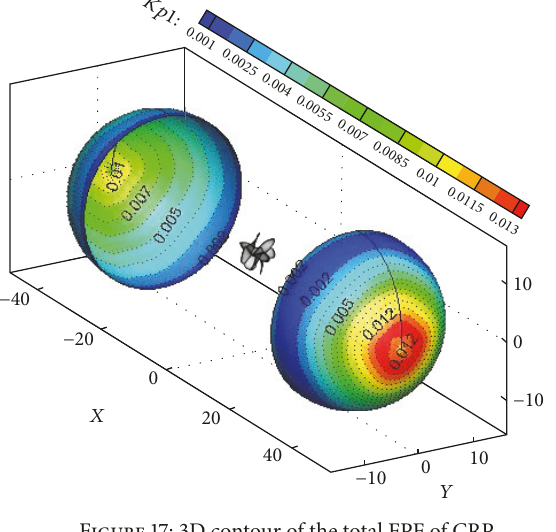
Figure 17: 3D contour of the total FPF of CRP.